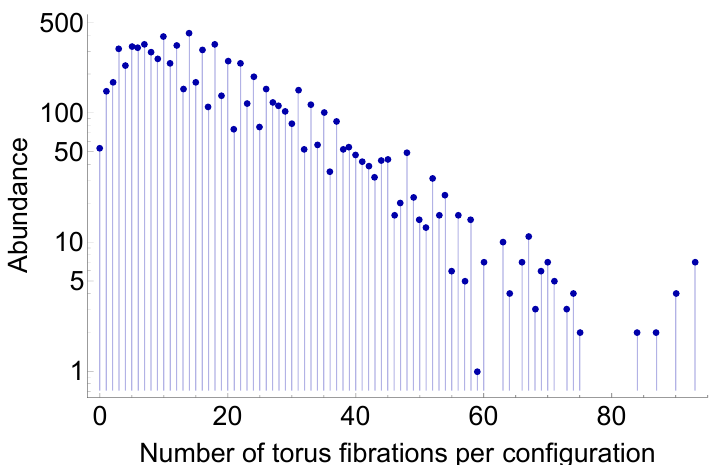
Figure 1 . Distribution of obvious torus (cid:12)bration abundance in the CICY threefold list (excluding product manifolds). The values lie in the range 0 - 93. We (cid:12)nd 139 ; 597 (cid:12)brations in total and on average each CICY threefold con(cid:12)guration is elliptically (cid:12)bered in 17 : 7 di(cid:11)erent